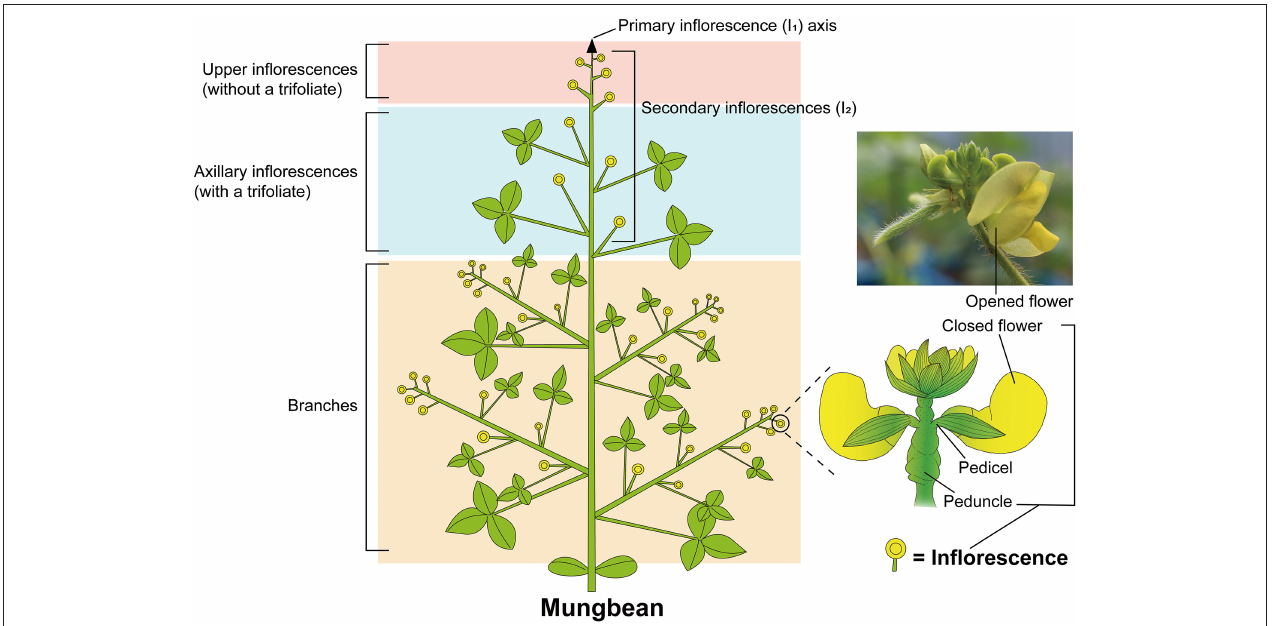
FIGURE 1 | Schematic diagram of mungbean plant architecture. Mungbean shows a typical compound raceme that bears flowers not on the primary inflorescence (I 1 ) but on secondary inflorescences (I 2 ). Each branch in the lower part repeats the combination of axillary and upper inflorescences of the main stem. Double circles represent inflorescences; arrow indicates the primary indeterminate inflorescence axis.